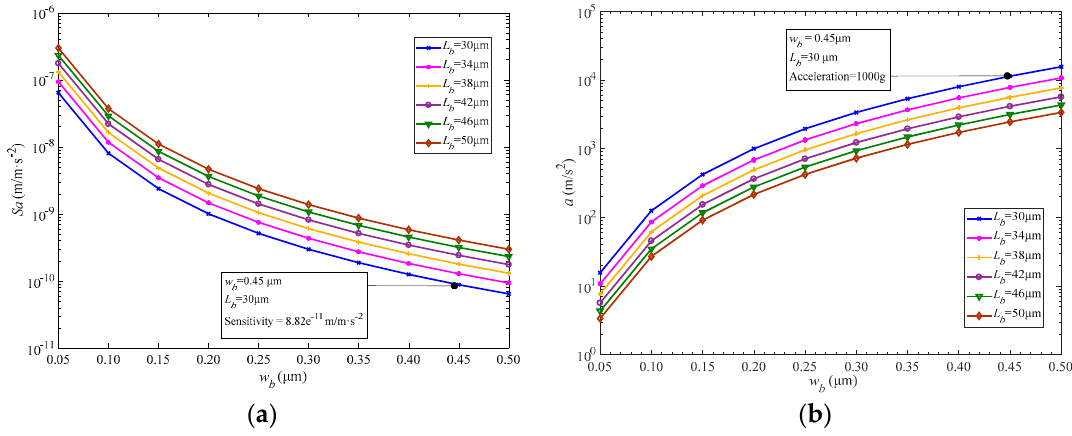
Figure 3. ( a ) Sensitivity and ( b ) acceleration as function of the dimension of support beam.